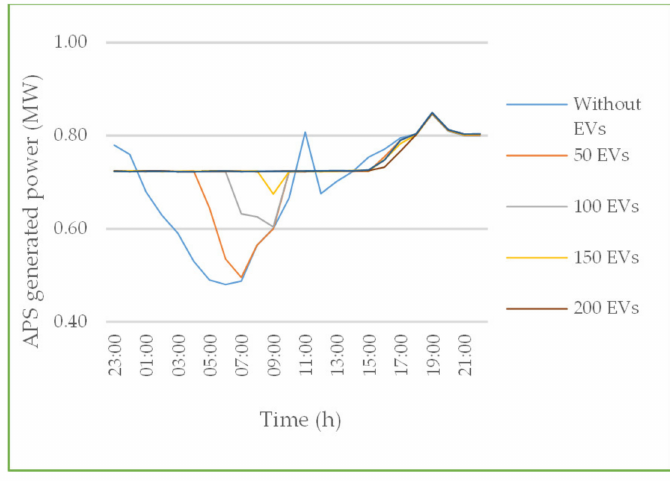
Figure 16. APS output required in the presence of a 140.0 kWp PV plant for test case 4 and LC2.